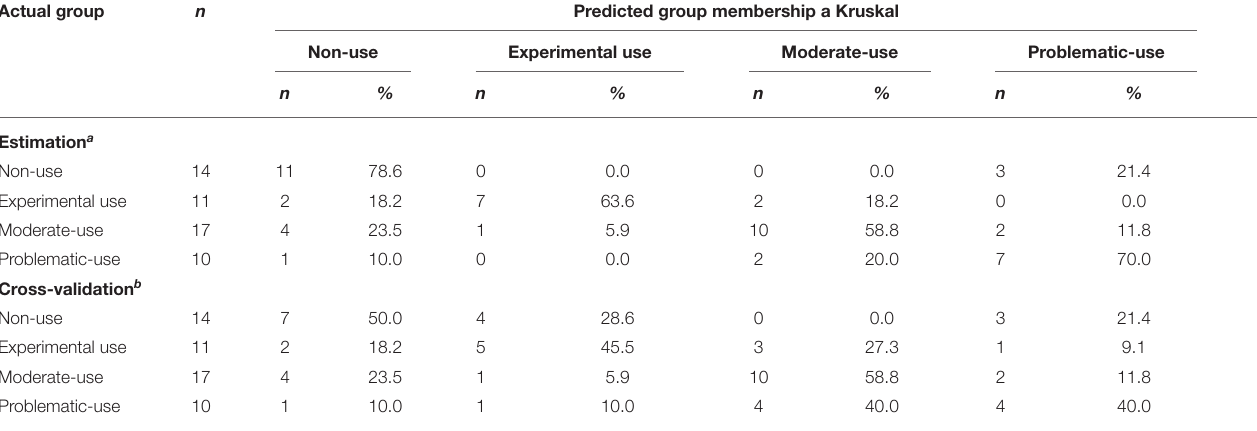
TABLE 4 | Classification analysis for type of drug involvement. Actual